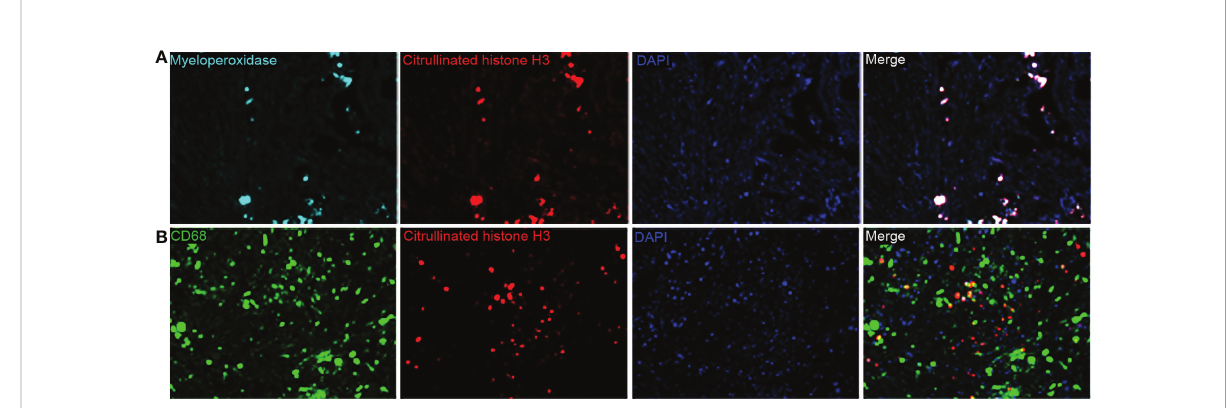
FIGURE 1 (A) Representative multiplex immuno fl uorescence staining images for myeloperoxidase-positive extracellular traps (ETs) and (B) macrophage ETs (magni fi cation, 400×).